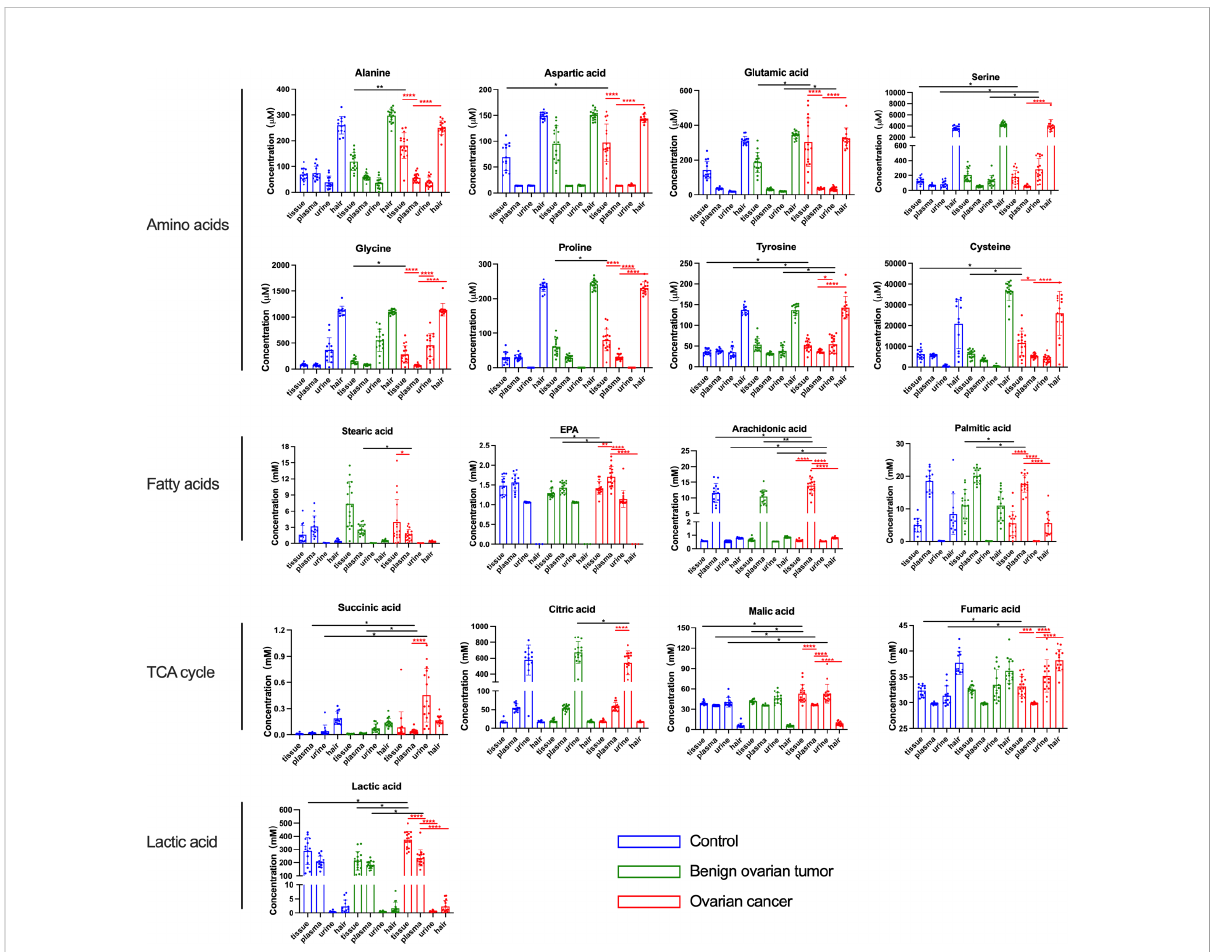
FIGURE 3 The concentration of amino acids, fatty acids, and lactic acid in the tissue, plasma, urine, and hair samples from control, benign ovarian tumor, and ovarian cancer patients. Blue circles represented metabolites levels collected from control patients, green circles represented metabolites levels collected from benign ovarian tumor patients, and red circles represented metabolites levels collected from ovarian cancer patients. Black asterisks (*) indicated metabolites with signi fi cantly different levels between ovarian cancer group vs. control group, and ovarian cancer group vs. benign ovarian tumor group using logistic regression with confounding factors together with a false discovery rate. Red asterisks (*) indicated a signi fi cant difference in metabolites between various sample types in the ovarian cancer group using Tukey ’ s Honest Signi fi cant Difference (HSD) test (*p-values< 0.05, **p-values < 0.01, ***p-values < 0.001, ****p-values < 0.0001). Only the signi fi cant metabolites with absolute quanti fi cation were displayed. Number of tissue sample in control group (n = 14), BOT group (n = 16), and OC group (n = 16). Number of plasma sample in control group (n = 13), BOT group (n = 16), and OC group (n = 17). Number of urine sample in control group (n = 13), BOT group (n = 15), and OC group (n = 17). Number of hair sample in control group (n = 13), BOT group (n = 16), and OC group (n =